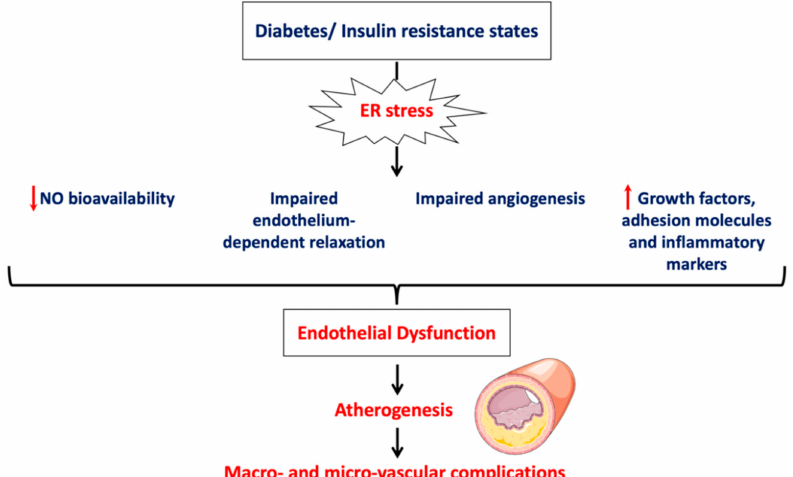
Figure 2. Characteristic features of endothelial dysfunction induced by diabetes through ER stress. In diabetes and insulin resistance states, ER stress was shown to be activated and mediate, in part, endothelial dysfunction, which is the first step in atherosclerosis leading to cardiovascular